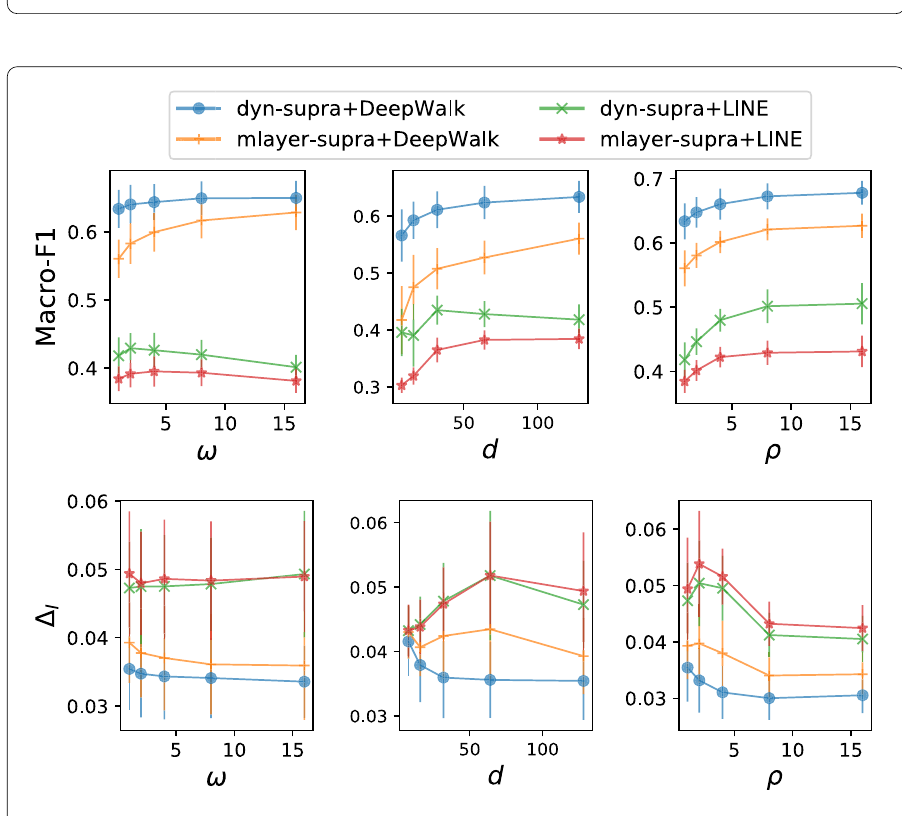
Figure 7 Results of the hyper-parameter sensitivity on the Macro-F1 and (cid:4) I performance measures for the InVS15 data set. Bars indicate the standard deviation. Here ( β , μ ) =